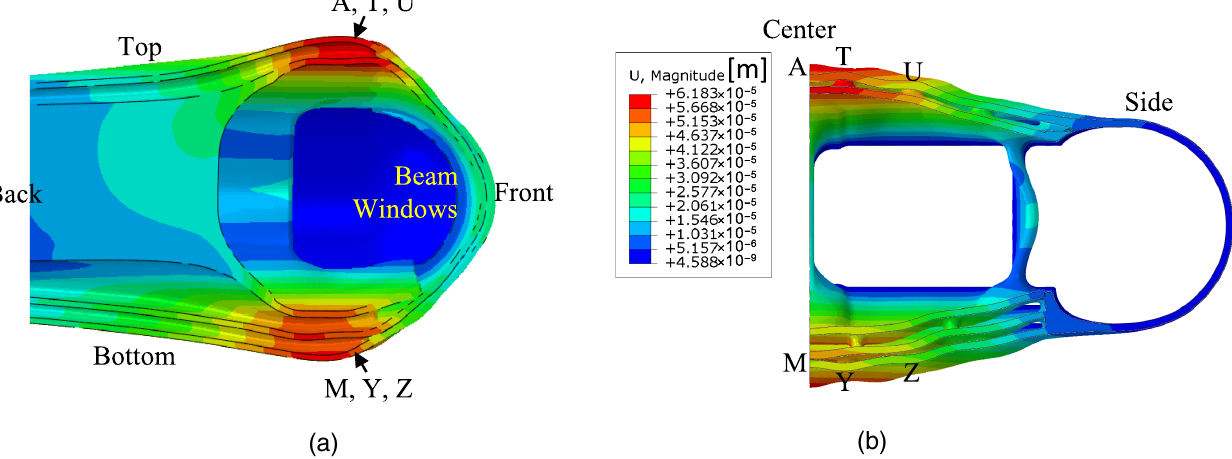
FIG. 11. Vessel deformation of the forward region at 0.08 ms (deformation is magnified 500 ×). (a) Side view and (b) front view with window